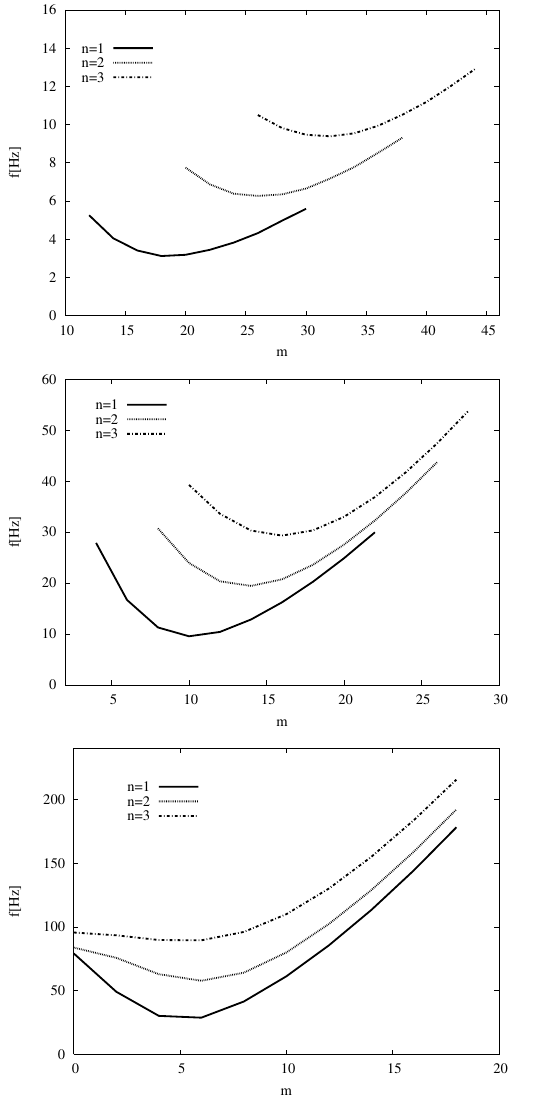
Figure 18: Third benchmark, simply supported plate embedding aluminium alloy and titanium alloy with thickness ratios a/h=1000 (top), a/h=100 (middle) and a/h=10 (bottom). First (I) 3D frequen- cies versus half-wave numbers m (from 1 to 10) and n (from 1 to 3). The behavior of frequency values and vibration modes versus imposed half-wave numbers has been investigated via the 3D exact model. The behavior is simple and eas- ily predictable for plate structures because the increas- ing of m and/or n values gives bigger frequency